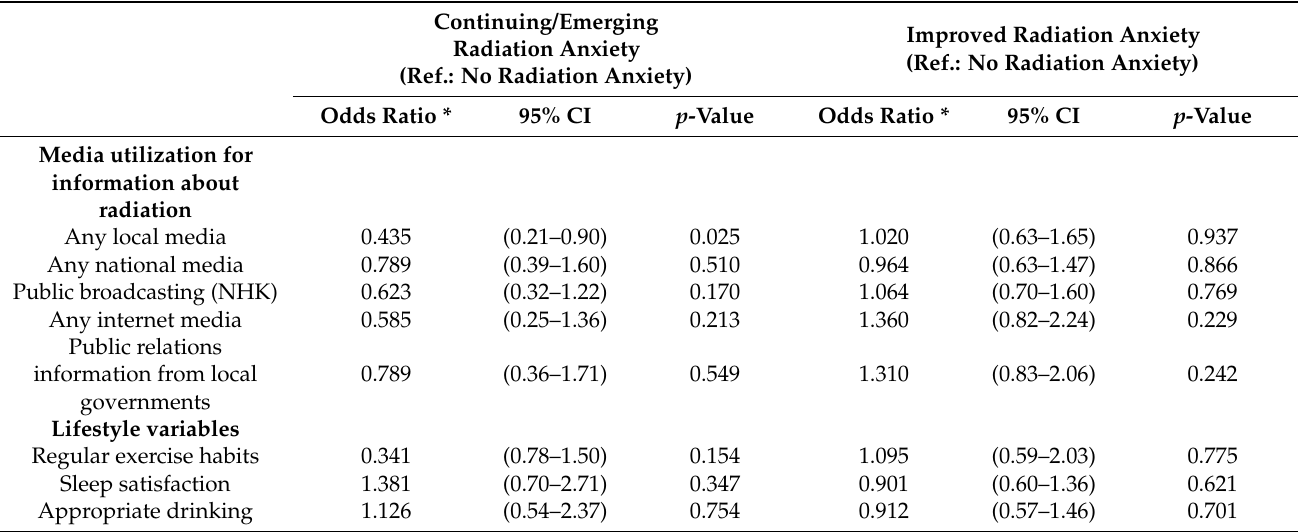
Table 6. Multivariate logistic regression analysis of media utilization and lifestyle variables related to health-promoting activities with current continuing/emerging, improved, and no strong health-related radiation anxiety. Continuing/Emerging Improved Radiation Anxiety Radiation Anxiety (Ref.: No Radiation Anxiety) (Ref.: No Radiation Anxiety) Odds Ratio * 95% CI Odds Ratio * 95% CI p